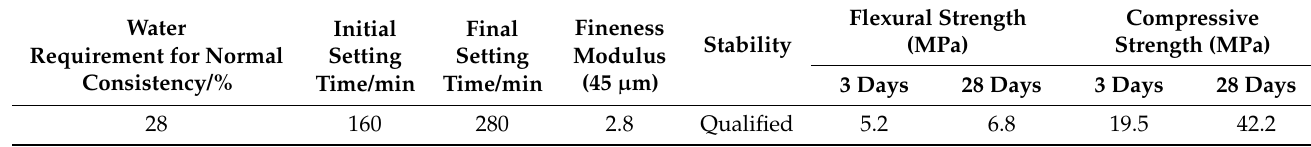
Table 3. Main performance indicators of cement.